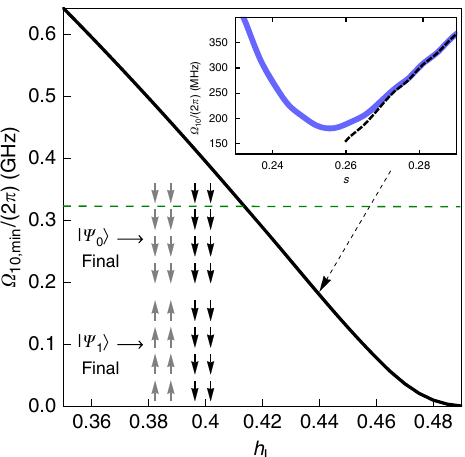
Figure 3 | Quantum energy gap. Inset shows the gap : O 10 ¼ E 1 ( s ) (cid:2) E 0 ( s ) versus s , using h L ¼ 0.44. The dashed line is the gap in the diabatic (pointer) basis. In the main plot, the minimum gap decreases with h L . The horizontal green dashed line (324MHz) corresponds to 15.5mK, the lowest temperature in our experiments. The lower inset shows the spin configurations of the two lowest eigenstates at the end of the annealing.